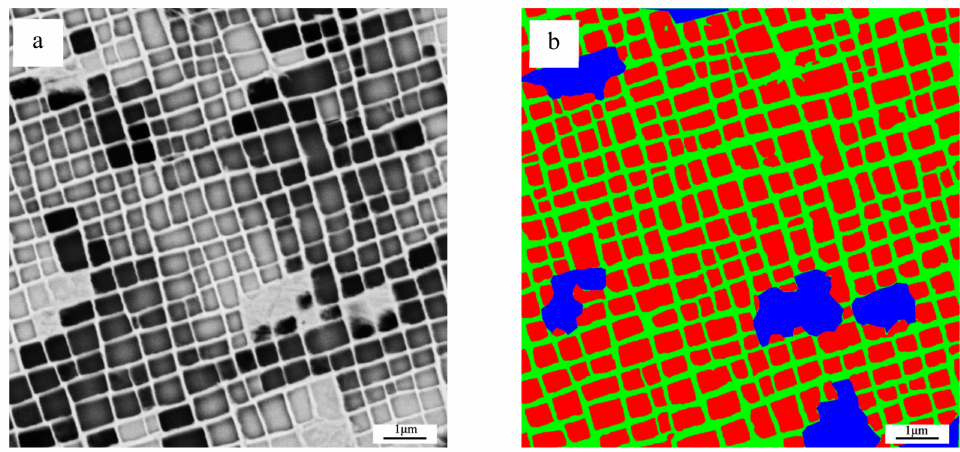
Figure 6. γ ’ phase identification and extraction results, ( a ) is the original SEM image, ( b ) is the recognition result, the red feature is the γ ’ phase, the green feature is the γ matrix, and the blue area is the unidentified interference.